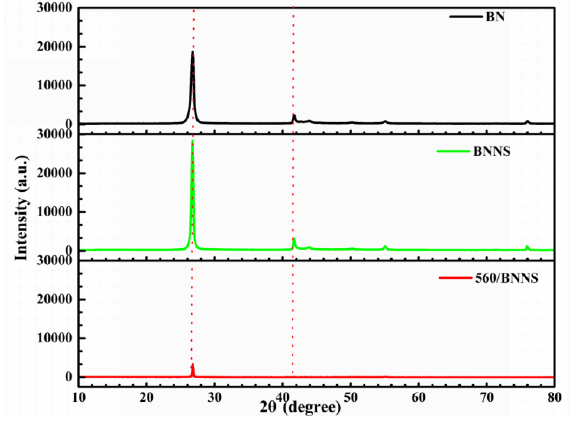
Figure 3. XRD result of h-BN, BNNS and 560/BNNS.